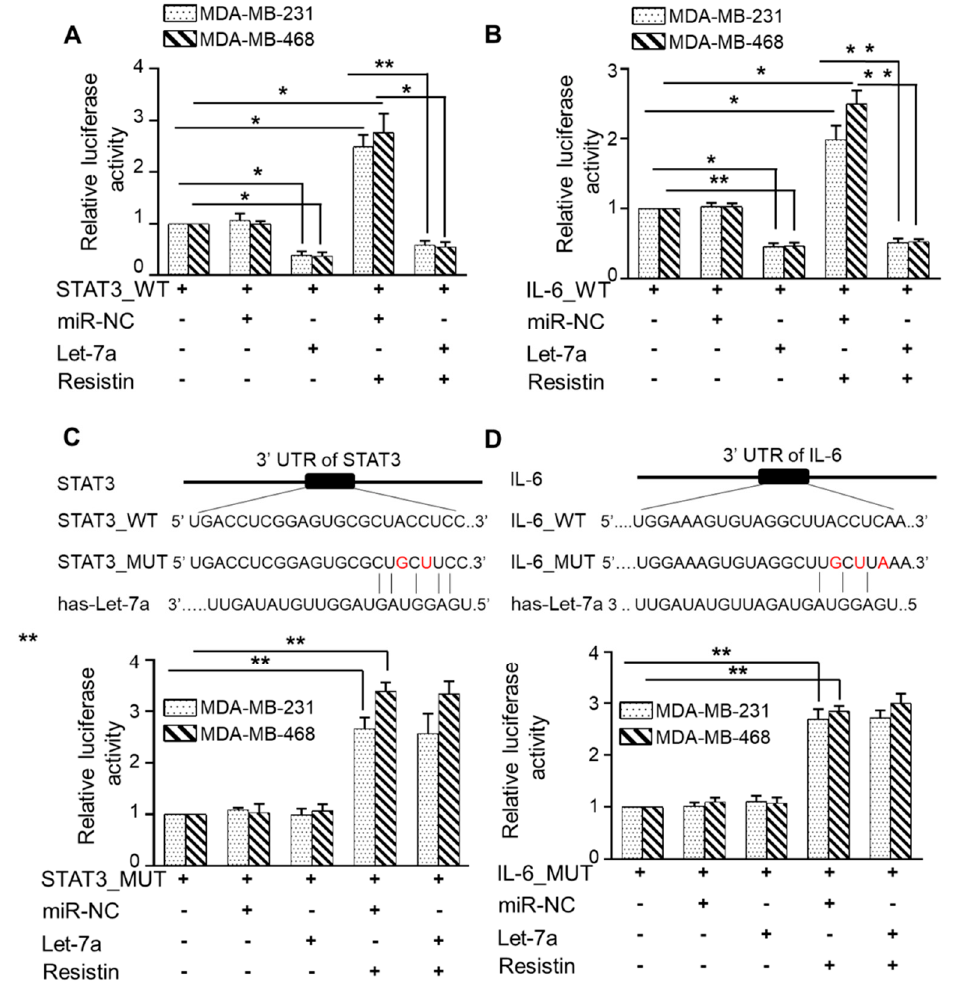
Figure 5. Let-7a suppresses STAT3 and IL6 expression in breast cancer cells by directly targeting their 3 (cid:48) untranslated regions. MDA-MB-231 and MDA-MB-468 cells were grown in 6-well plates and transiently co-transfected with luciferase reporter plasmids containing either STAT3 3 (cid:48) UTR ( A ) or IL6 3 (cid:48) UTR ( B ) and miR control (miR-NC) or Let-7a. Following 24 h of transfection, cells were treated with resistin for the next 24 h, and total protein lysates were made in the passive lysis buffer. Luciferase activities were measured using a dual-luciferase assay system. To ascertain that the effect of Let-7a on luciferase activity was due to its direct binding, we mutated 3 (cid:48) UTRs of STAT3 ( C ) and IL6 ( D ) as indicated. Data (mean ± SD.; n = 3, **, p < 0.005) is presented as fold change in normalized luciferase activity. * p < 0.05, ** p <